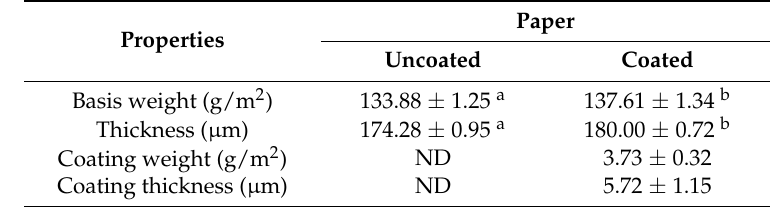
Table 3. The basis weight, thickness, coated weight, and coating thickness of the uncoated and coated paper.